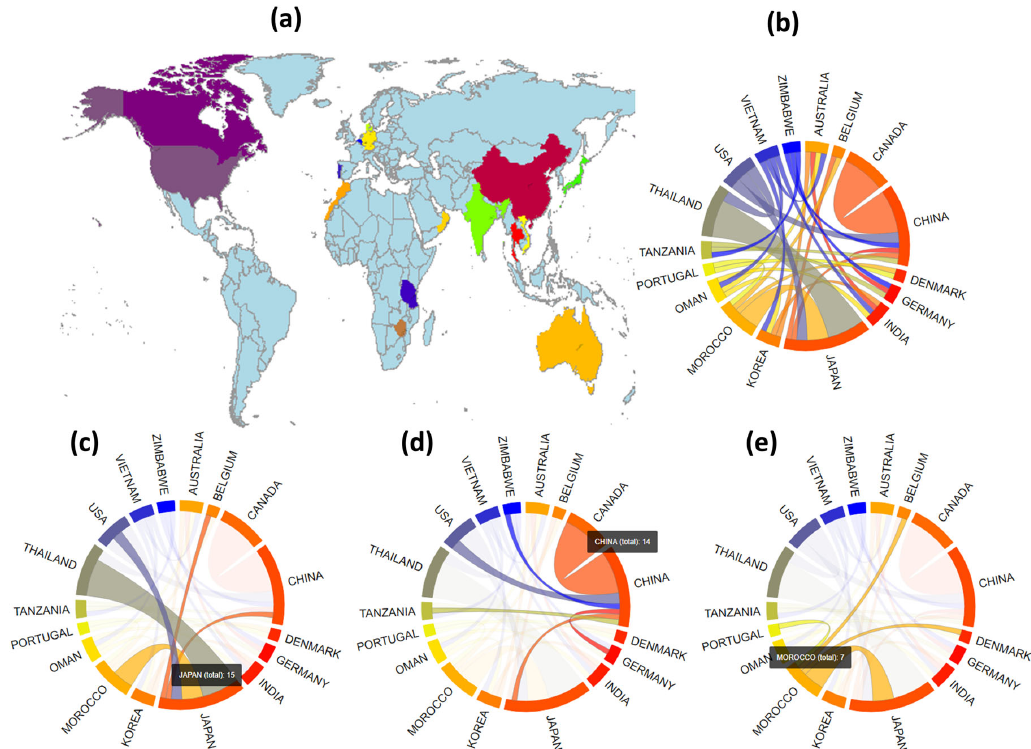
Figure 2. Spatial distribution map of collaborated countries in the MSL field; ( a ) country collaboration map, ( b ) country collaboration diagram, ( c ) Japan collaboration network, ( d ) China collaboration network, ( e ) Morocco collaboration network; each collaborative relationship is indicated by a specific color and its importance increases with the thickness of lines connecting two countries.